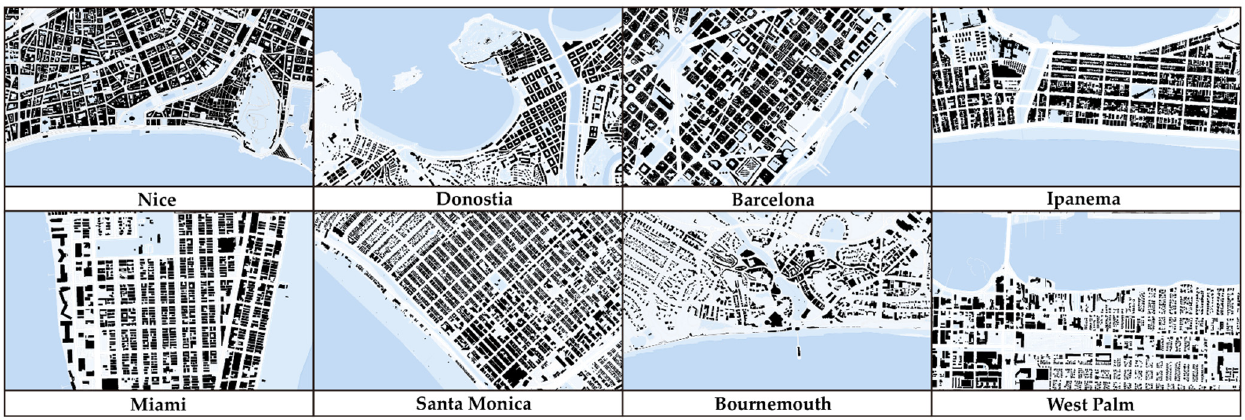
Figure 9. The number of blocks led by the different building types and the distribution of building types.